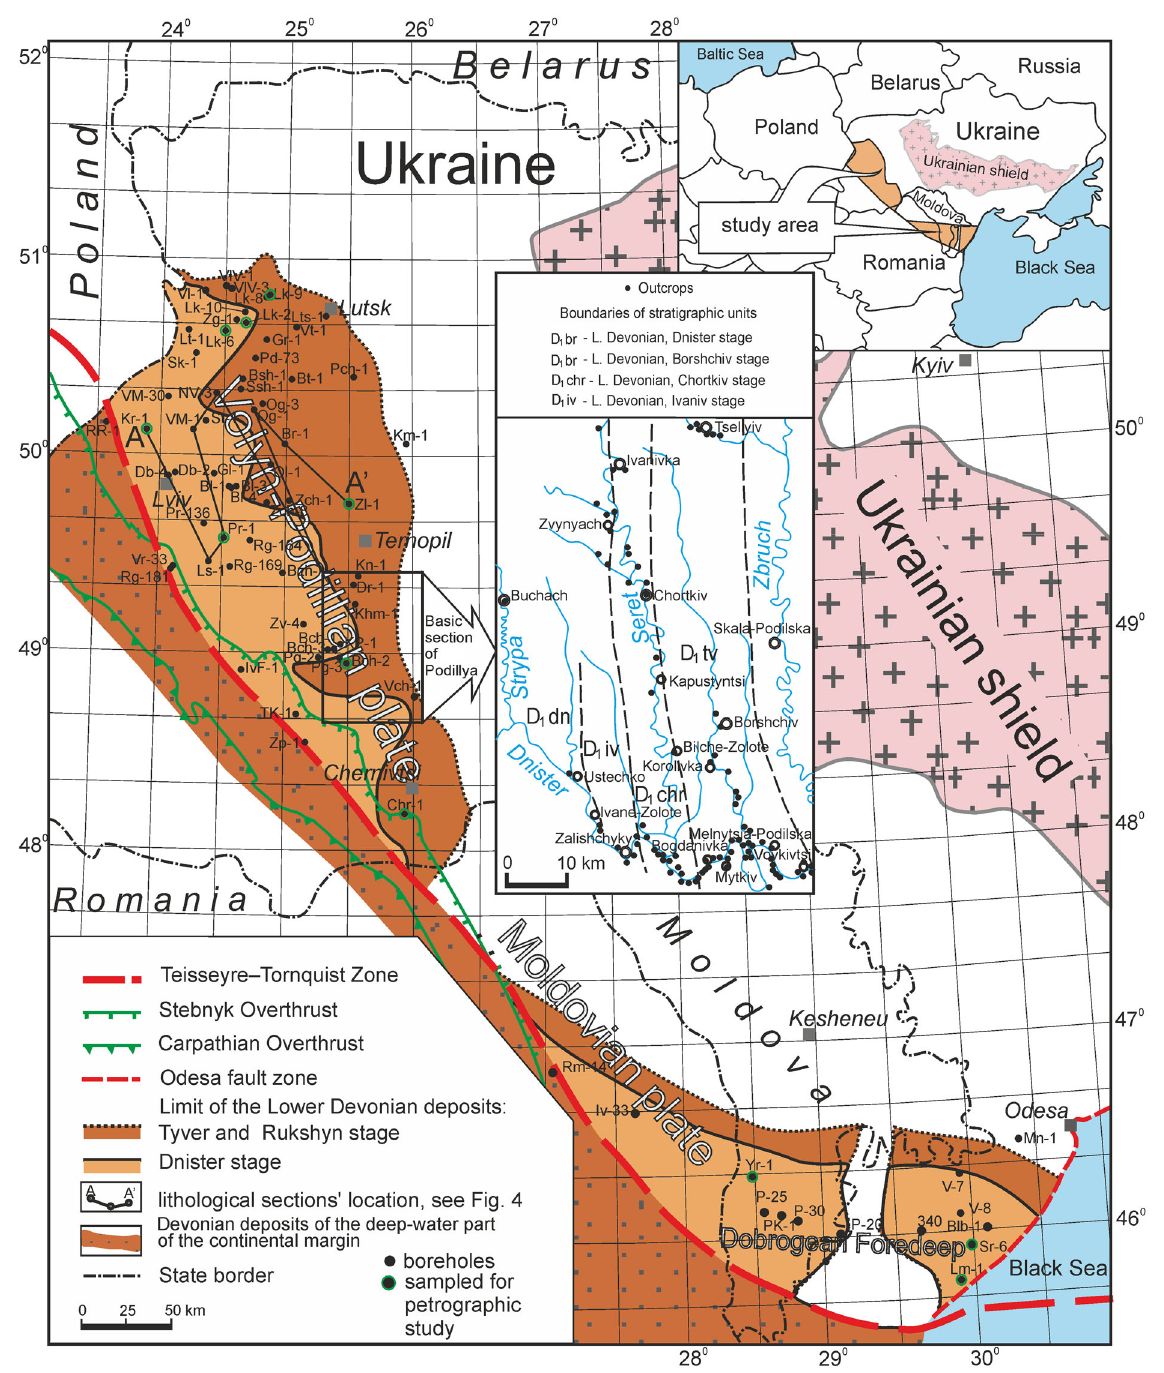
Fig. 1. Location map, showing the generalized distribution of Lower Devonian rocks in the southwestern margin of the East European Platform and the locations of boreholes. For the location of lithological sections see Fig. 4. Boreholes: Bch,